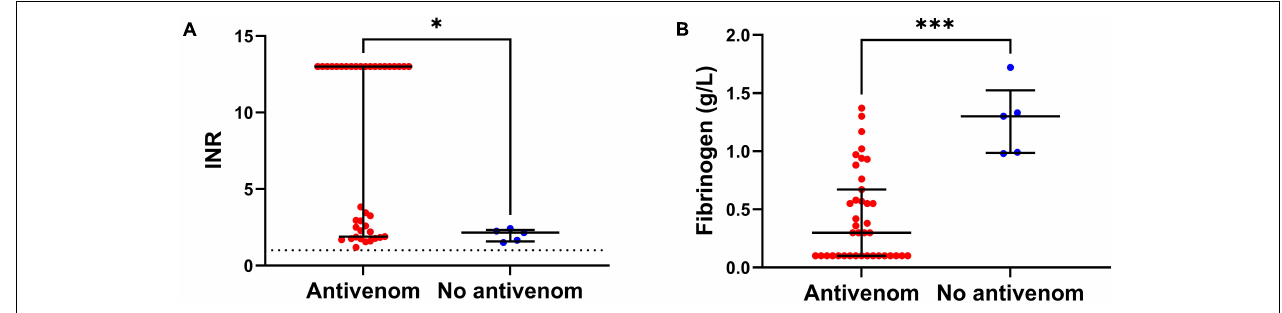
FIGURE 1 | (A) Comparison of the peak International Normalized Ratio (INR) of patients from antivenom and no antivenom groups. (B) Comparison of the minimum plasma fibrinogen concentrations of patients from antivenom and no antivenom groups. Note, the antivenom group had higher peak INR and lower minimum plasma fibrinogen levels compared to the no antivenom group ( ∗ p < 0.05, ∗∗∗ p < 0.001, Mann-Whitney test; horizontal bars represent median and interquartile